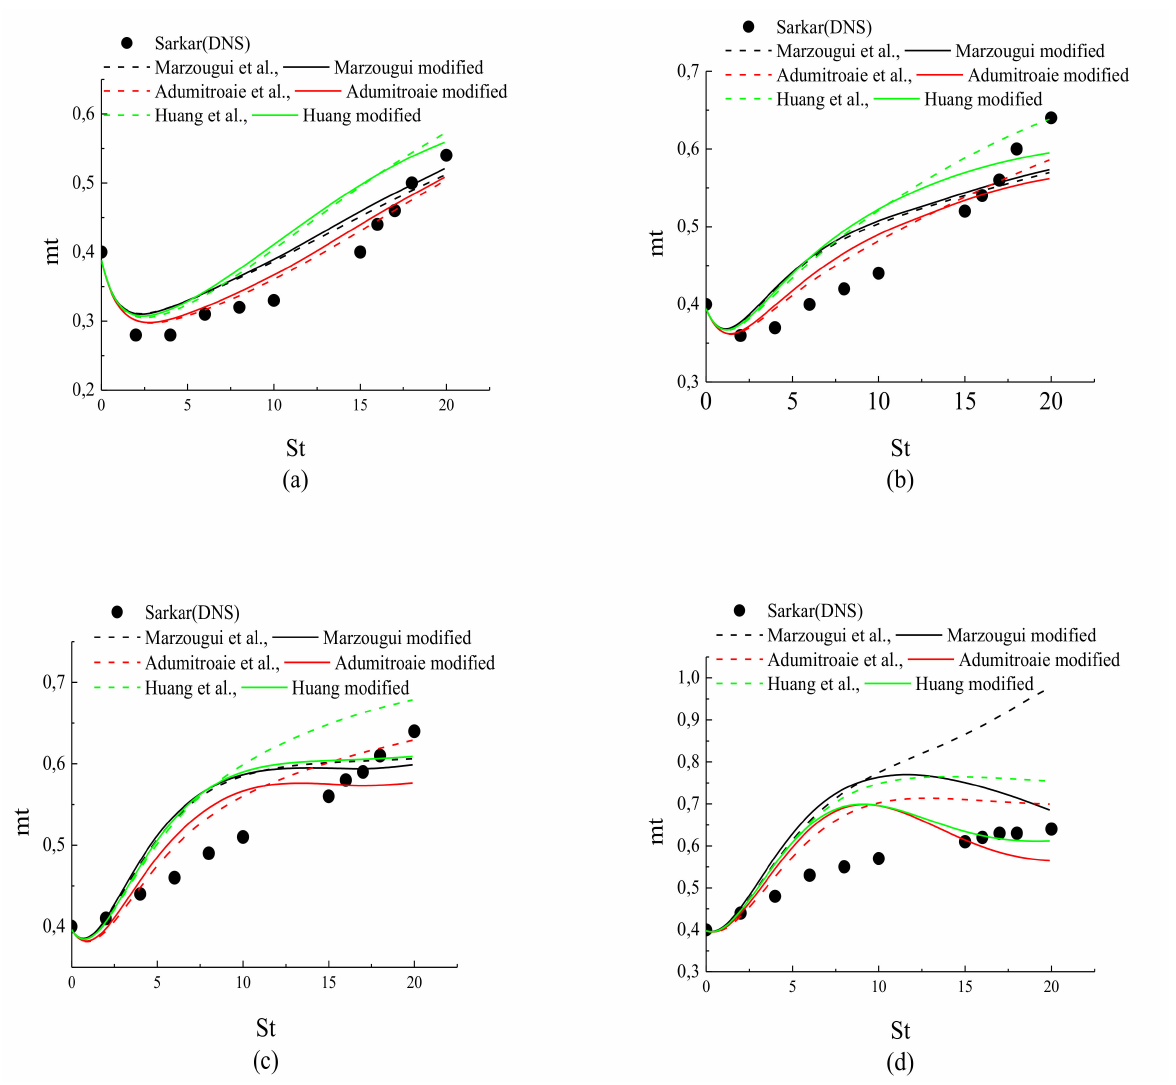
Figure 2. Time evolution of the turbulent Mach number, in the following cases: ( a ) A1; ( b ) A2; ( c ) A3;